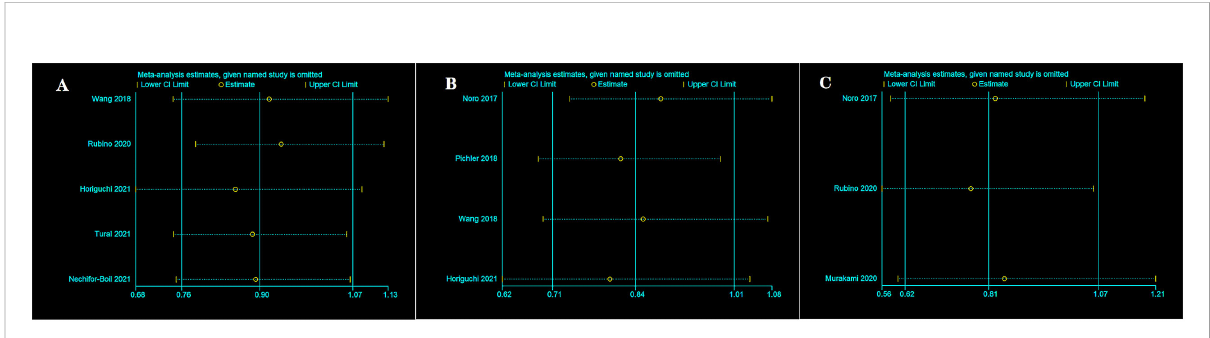
FIGURE 5 Sensitivity analysis between two group in TCs after surgery 5 years. OS (A) , RFS (B) , and CSS (C)